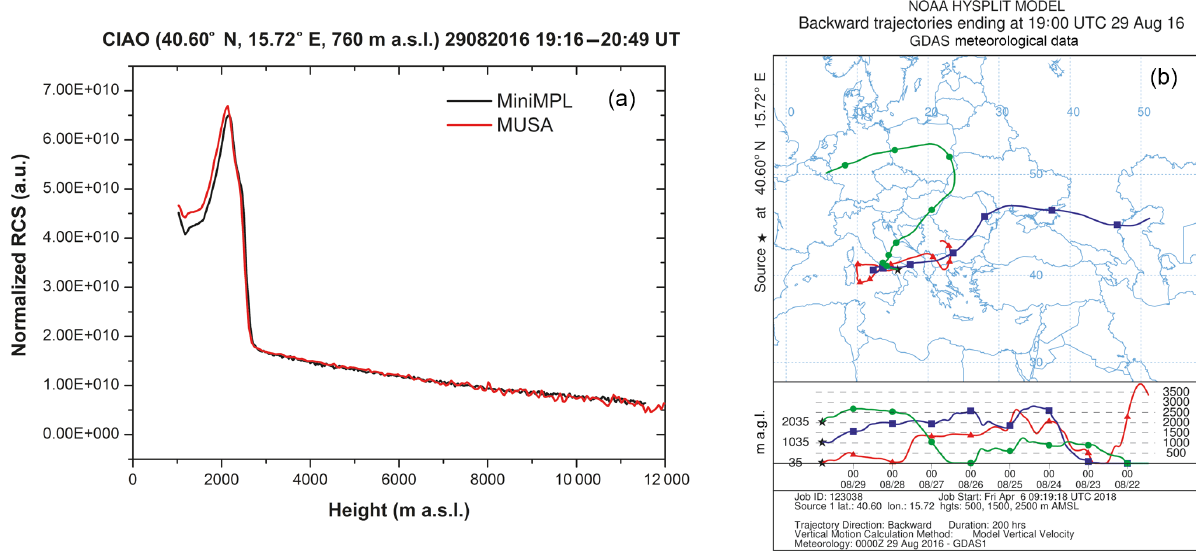
Figure 3. (a) Comparison between RCS profiles obtained from MUSA and MiniMPL on 29 August 2016 from 19:16 to 20:47UT; (b) the corresponding air mass back-trajectory analysis performed using NOAA HYSPLIT model. HYSPLIT simulations have been initialized at the three levels from the ground to the top height of the highest layer observed by both MUSA and MiniMPL.